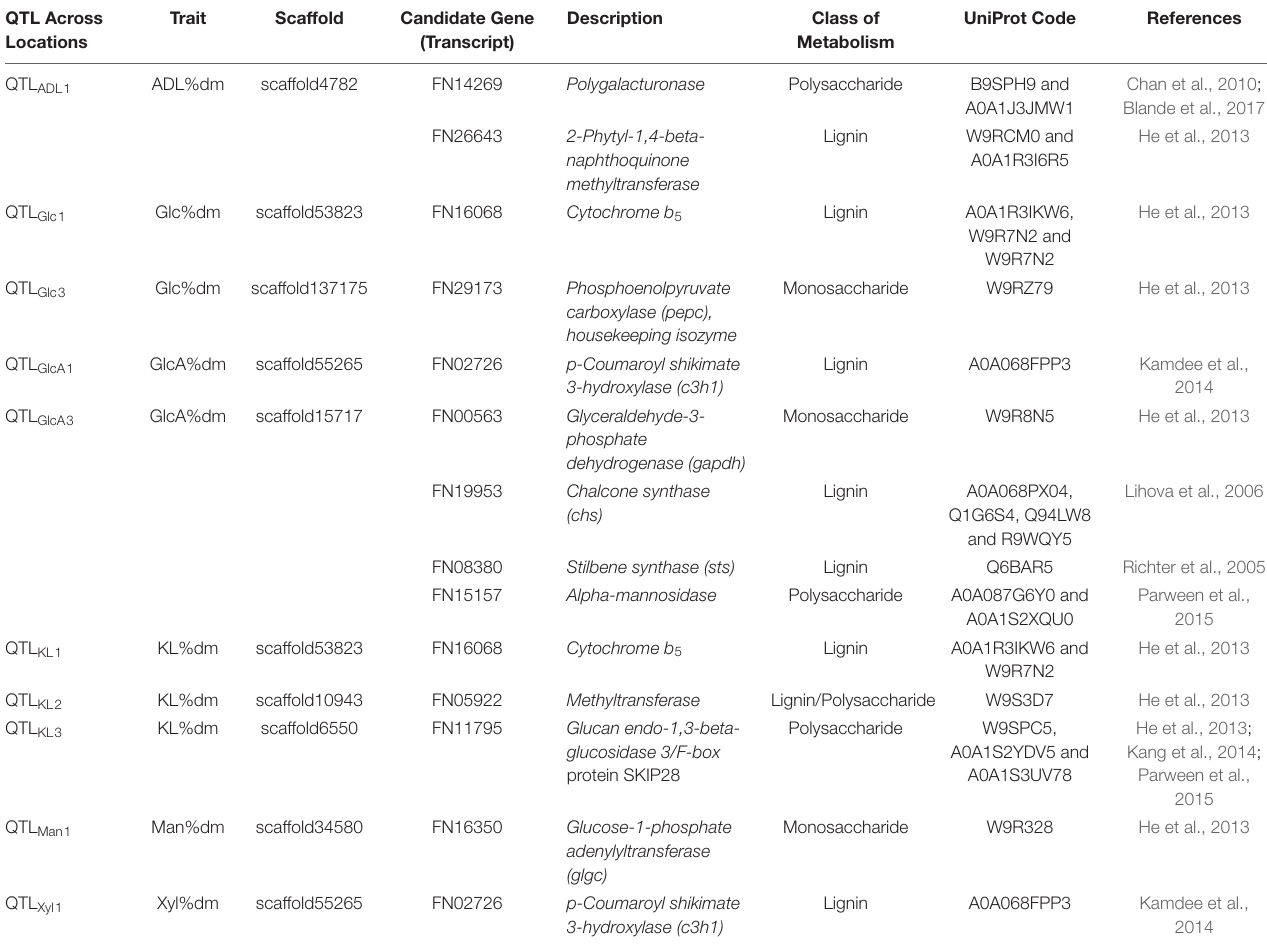
TABLE 4 | Putative candidate genes in quantitative trait loci (QTLs) across locations associated to fiber quality traits. QTL Across